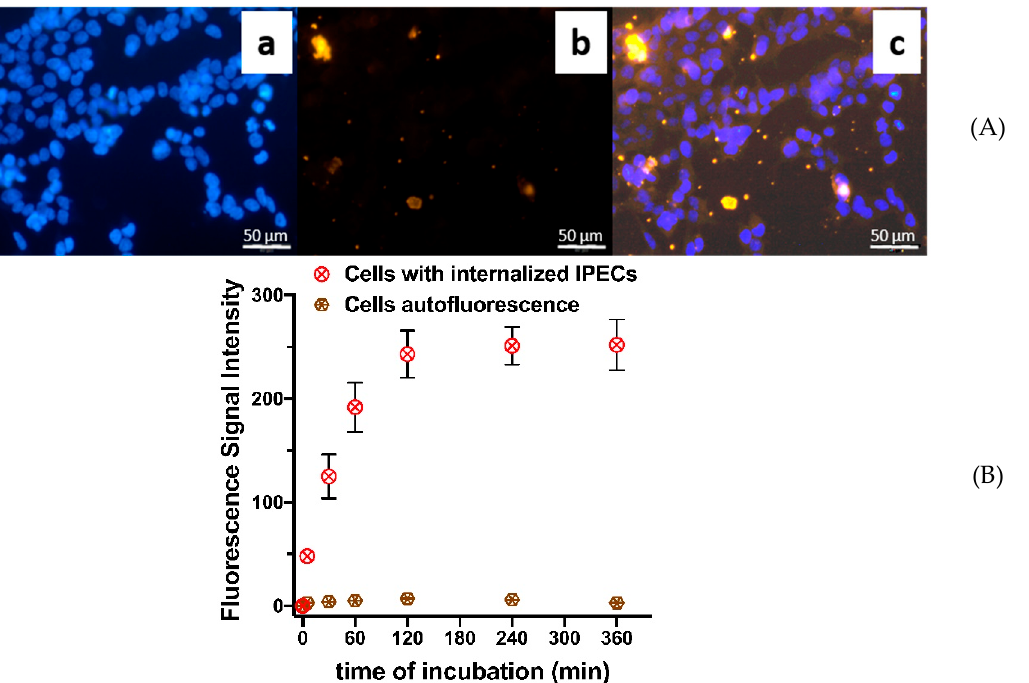
Figure 10. IPECs cellular internalization studies: ( A ) Visualization of IPECs cellular internalization by fluorescent microscopy: a —DAPI-stained cells; b —Cy5-labeled IPECs; c —merging of a and b. Time of co-incubation—2 h; ( B ) Fluorescence signal intensity after incubation of HEK 293 cells with cross-linked IPEC ([Lys–NH 3+ ]:[Hep–SO 3 − ]:[linker] = 1:3:0.8). The IPEC concentration—0.1 mg/mL. The data